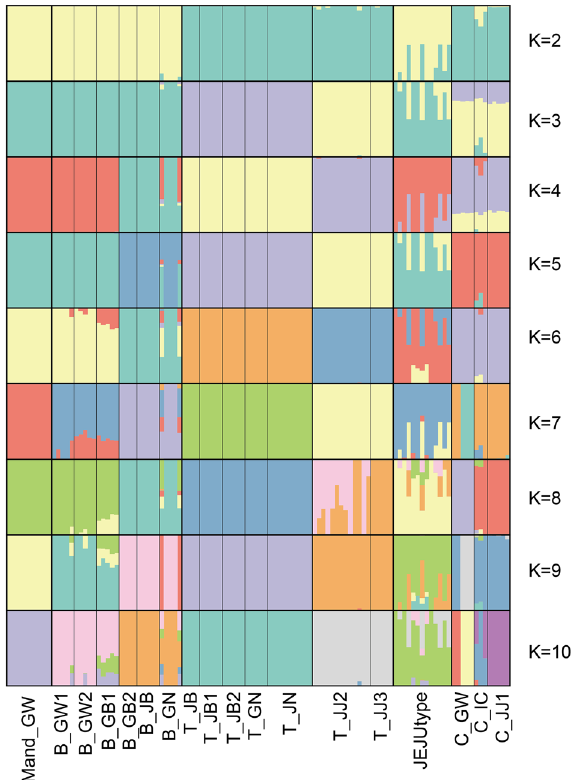
Figure 5. Genetic population structure prediction (K = 2–10). The distribution of the accessions to different populations is indicated by the color code.